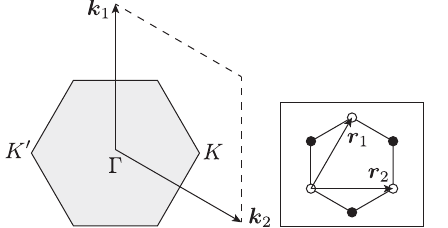
FIG. 2. Brillouin zone (gray region) of the honeycomb lattice. k 1 , k 2 are the translation basis of the momentum space, dual to the real space translation basis r 1 , r 2 , as shown in the inset. K , K 0 are the two gapless points when λ ¼ 0 .